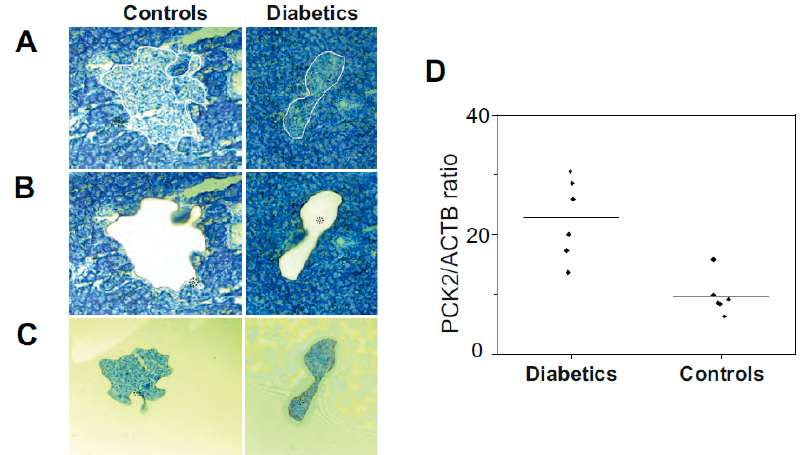
Figure 7. LCM dissection of Langerhans islets from rat pancreas: Hematoxylin-stained pancreatic tissue of 14 µ m thickness on laser microscope at 10 × resolution. ( A ) Langerhans islets were marked for cutting through laser. ( B ) Stained tissue sections after cutting of Langerhans islets. ( C ) Captured β -cells after laser cutting. ( D ) Capillary western blot of dissected Langerhans islets from diabetic rat ( n = 6) versus control rat ( n = 6). The signal ratio of PCK2/ACTB in diabetic and control groups (mean of technical replicates) was analyzed by t